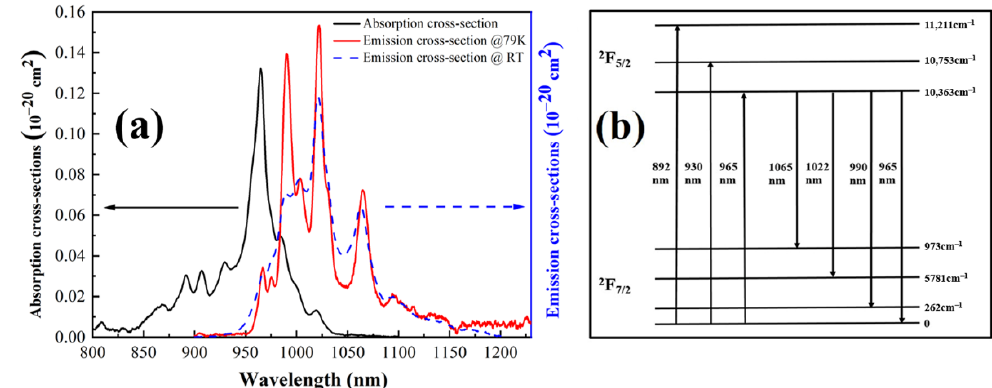
Figure 4. ( a ) Emission cross-section spectra (RT and 79K) and absorption cross-section (RT) spectra; ( b ) diagram of energy level. (Source: [34], © 2015 Optica Publishing Group, Washington, DC, USA).